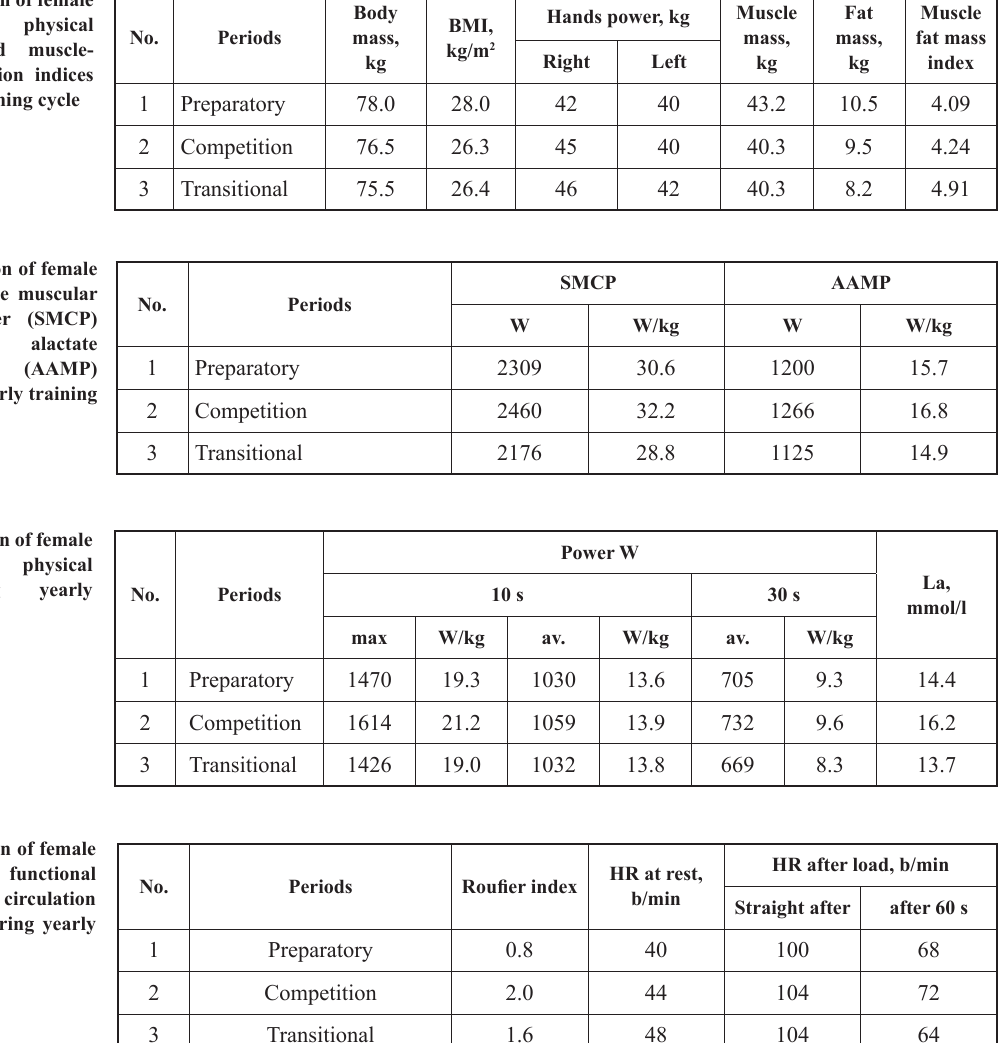
Table 1. Alternation of female BMX cyclist’s physical development and muscle- fat mass correlation indices during yearly training cycle